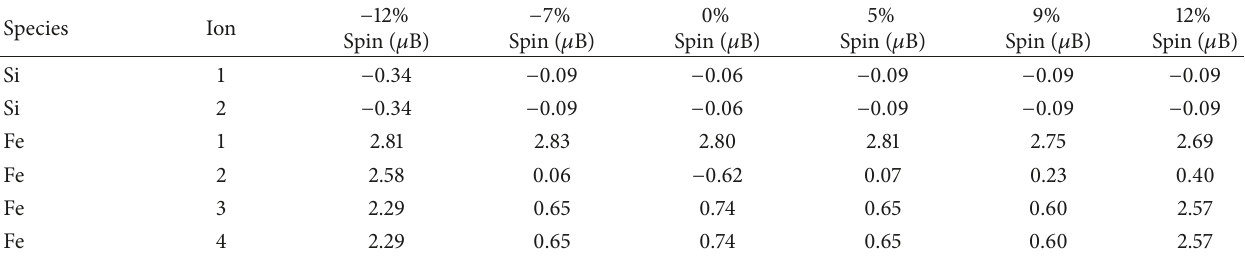
Table 1: Magnetic moments of all of the atoms in the Fe 2 Si unit cell under various strains. − 12% − 7% Species Ion Spin ( 𝜇 B) Spin ( 𝜇 B) Si 1 − 0.34 − 0.09 Si 2 −